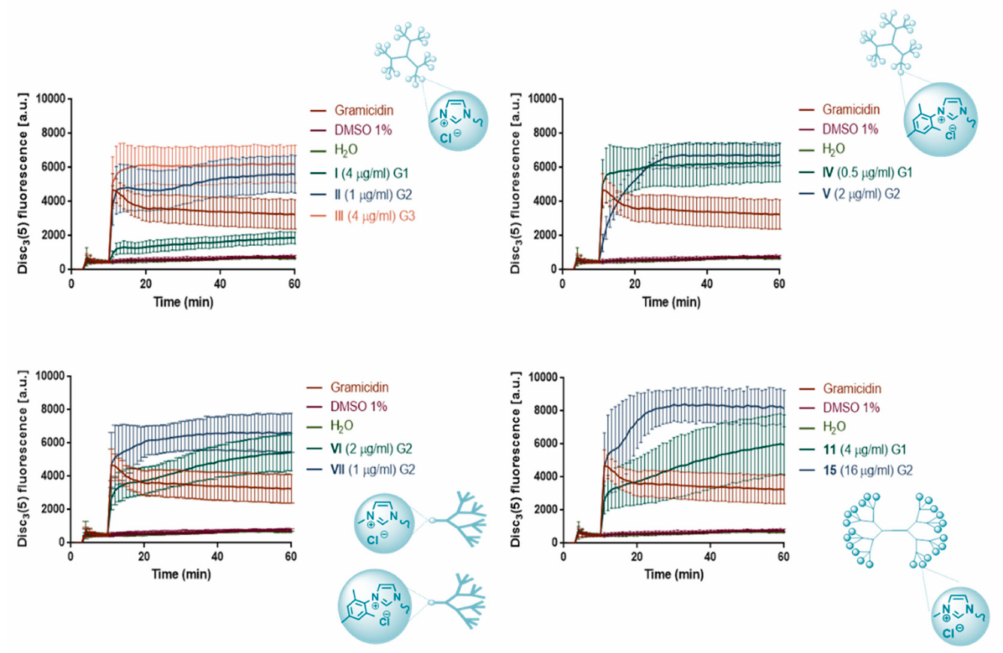
Figure 3. Disc 3 (5) fluorescence graphs cell membrane depolarization of B. subtilis WT168 in the presence of compounds I–VII, 11, and 15 with the corresponding schematic representation of